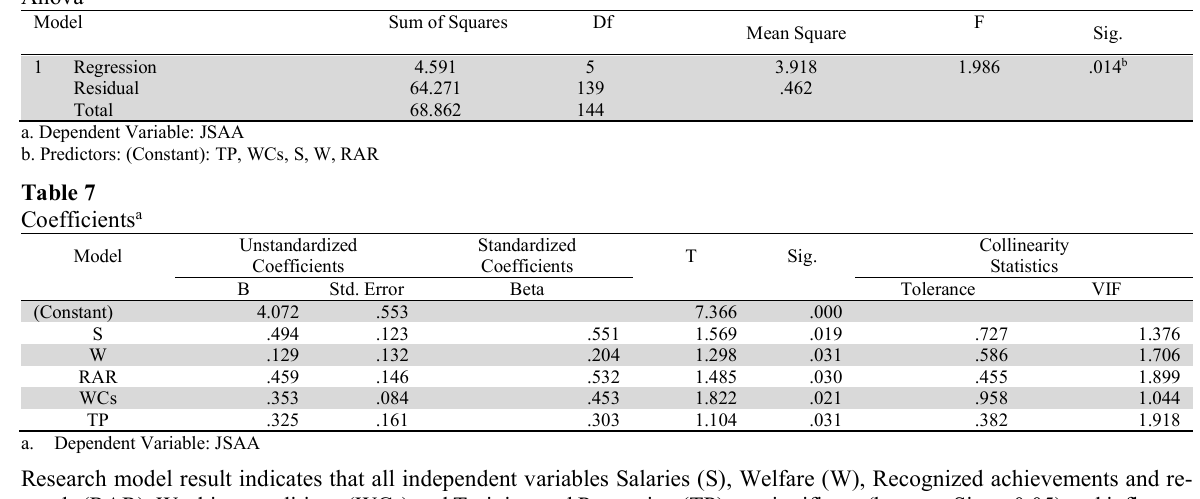
Anova a Model Sum of Squares Df Regression Residual